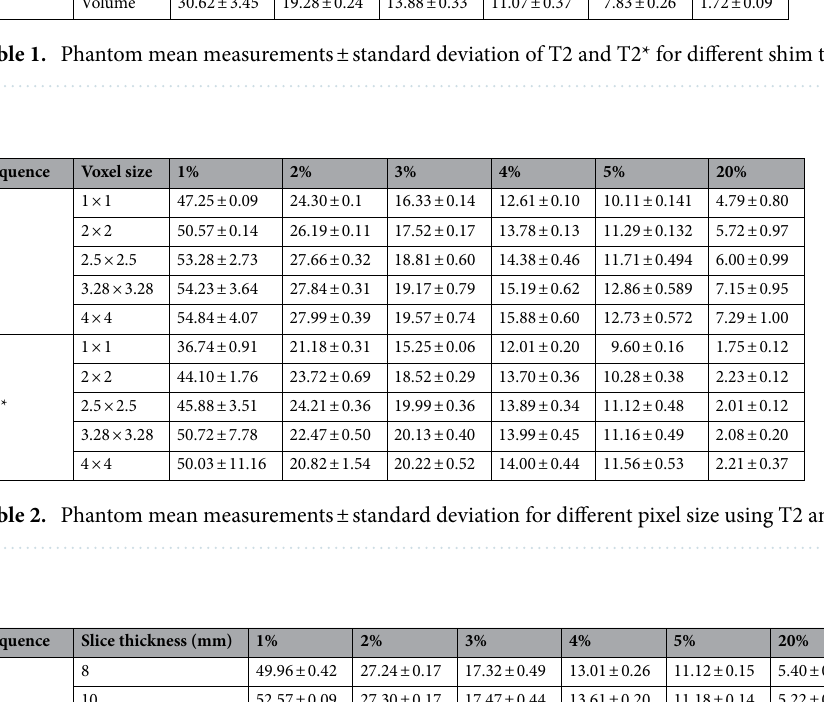
Table 1. Phantom mean measurements ± standard deviation of T2 and T2* for different shim techniques.